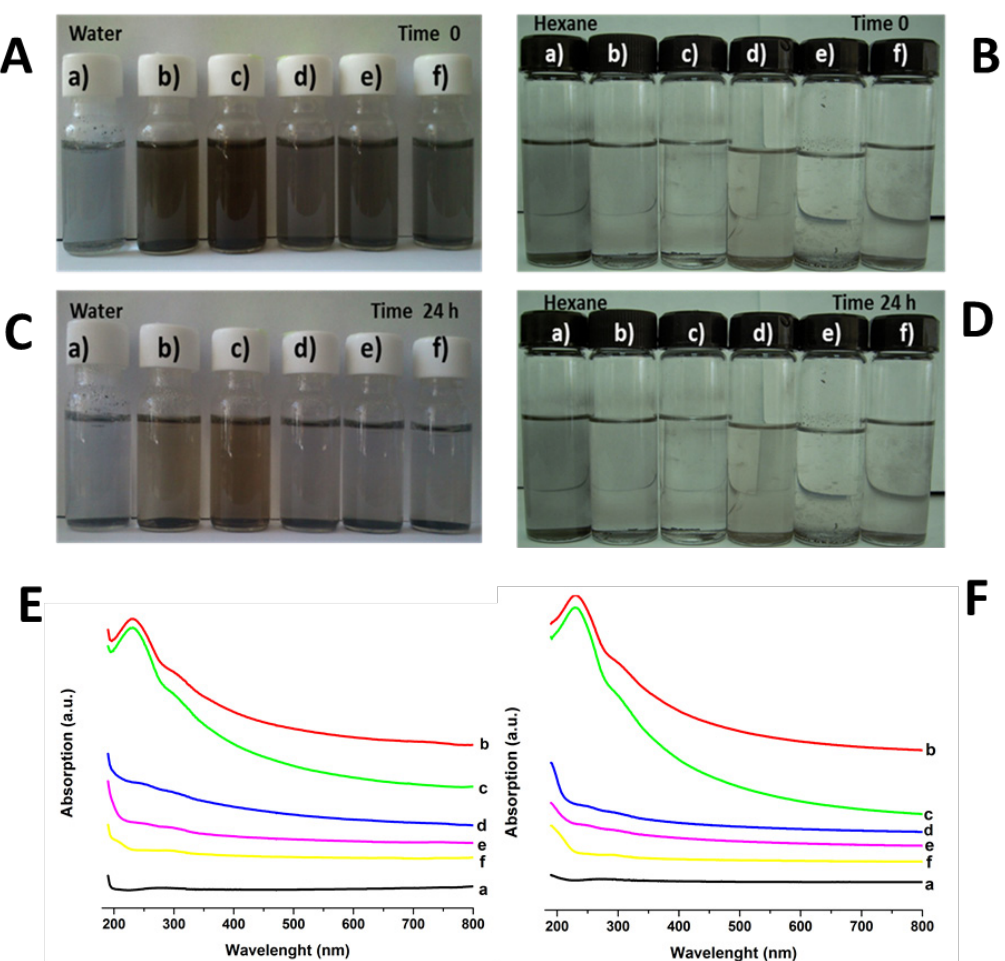
Figure 5. Dispersion study of: ( A ) water after sonication; ( B ) hexane after sonication; ( C ) water after sonication and 24 h kept at rest; ( D ) hexane after sonication and 24 h kept at rest; ( E ) UV-Vis spectra of samples dispersed in water after sonication; ( F ) UV-Vis spectra of samples dispersed in water after sonication and 24 h kept at rest: ( a ) graphite; ( b ) GO; ( c ) GEO; ( d – f ) chitosan-grafted graphene oxide at: ( d ) CGEO1; ( e ) CGEO2; ( f )